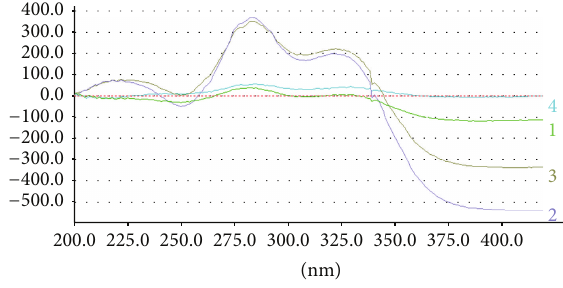
Figure 6: UV spectra of BZ4 standard (1, 2) and shampoo sample (3, 4) collected directly from the chromatographic plate in the reflectance